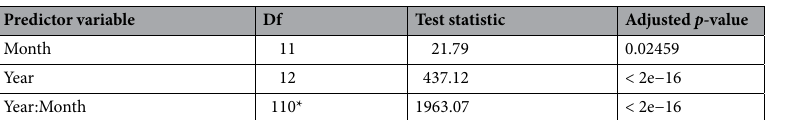
Table 2; p < 0.001 ), but also that there is an interaction between months and years (Table 1; p < 0.001 , Table 2; p < 0.001 ; Fig. 10). This provides evidence to suggest that there is variation in the pattern of whale songs across years at both sites. Although Chagos songs were detected throughout the year, there were more songs detected at restricted times (Fig. 10). The timing of peaks in song detection was different between the sites. At DGN most songs were detected in 2 to 3 months, whereas at DGS songs were detected over a longer period, from 2 to 6